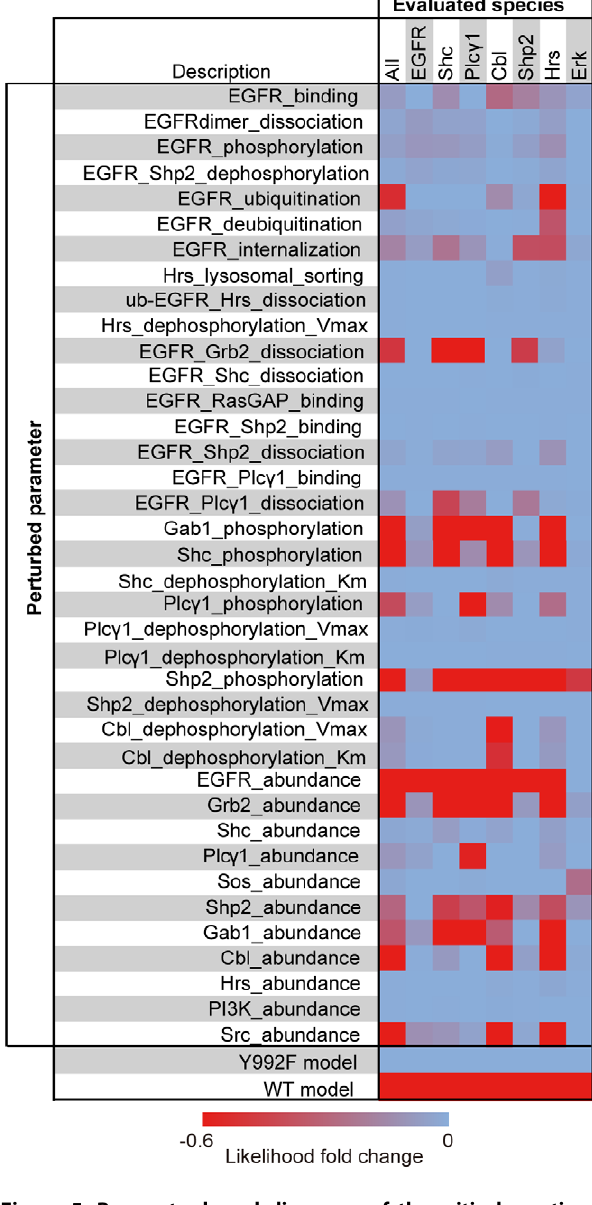
Figure 5. Parameter-based discovery of the critical reactions governing Y992F signaling. Each of the 38 estimated parameters in the Y992F model was reset to the value in the WT model, and the likelihood for the measured data was evaluated. The color bar shows the log-transformed fold change of the likelihood against the value in the original Y992F model. The likelihood for all the observed data was calculated as a geometric average of the likelihood for the data for each protein. The likelihood regarding the WT and Y992F models is indicated as positive and negative controls, respectively.